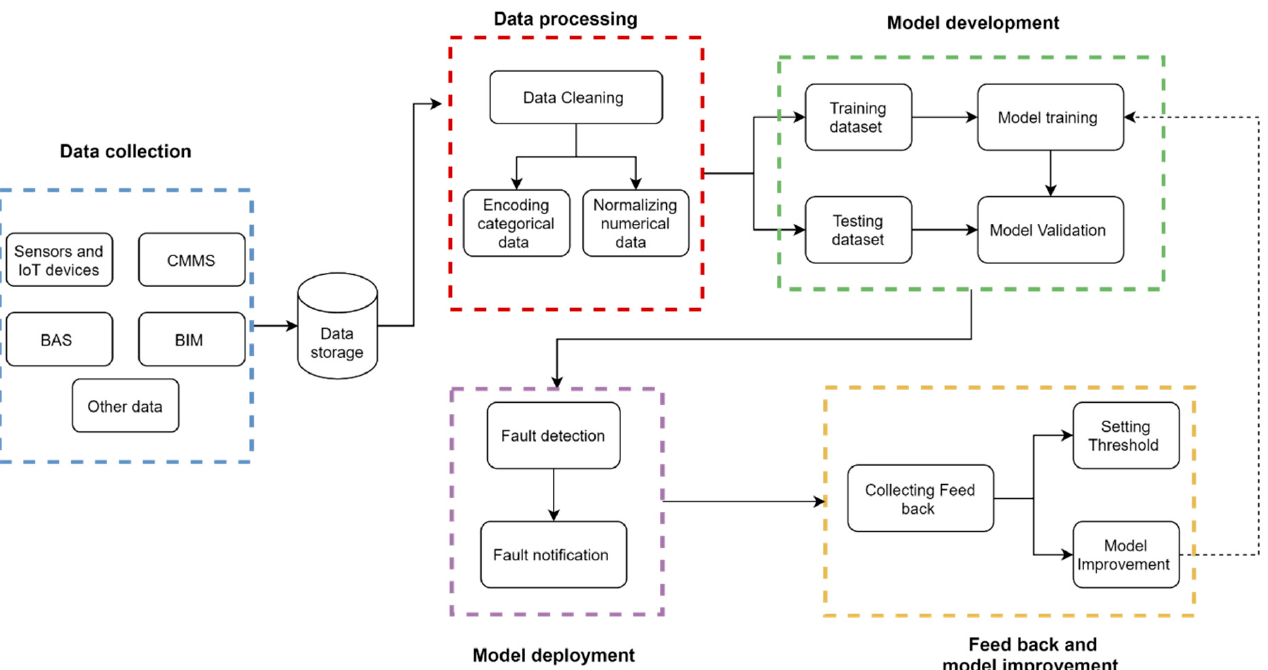
Figure 2. The proposed framework architecture.